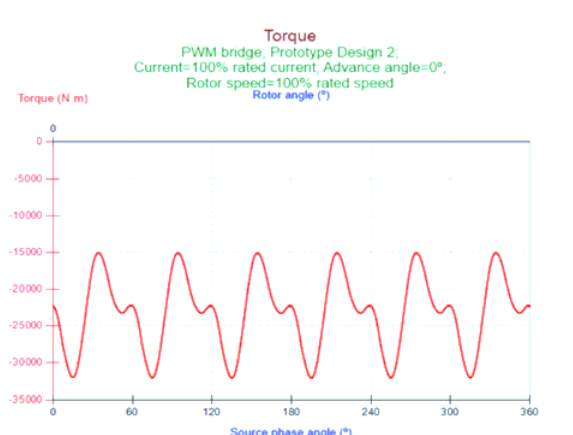
Figure 2. Power-angle curves